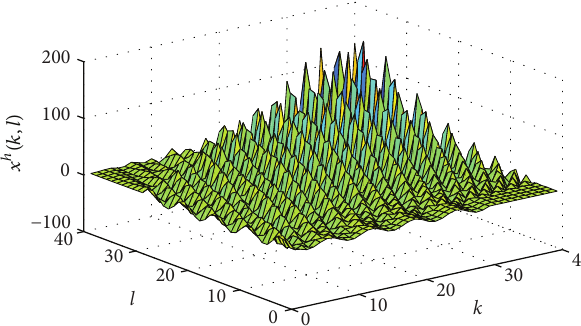
𝑥 ℎ (𝑘, 𝑙) and 𝑥 V (𝑘, 𝑙) with 𝛼